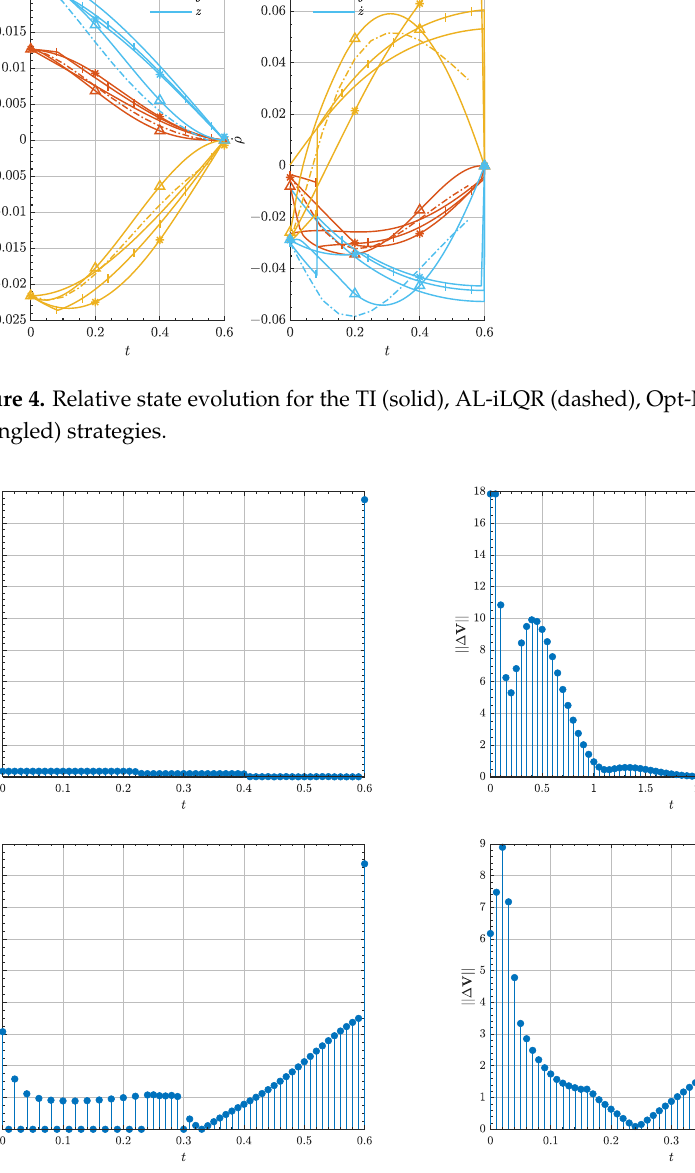
Figure 5. Impulse sequence in m/s for the Opt-MI/MPC ( upper left ), AL-iLQR ( upper right ), MISG/DC ( lower left ) and MISG/MPC ( lower right )